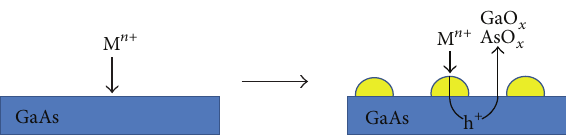
Figure 1: Mechanism of galvanic displacement of GaAs substrate with